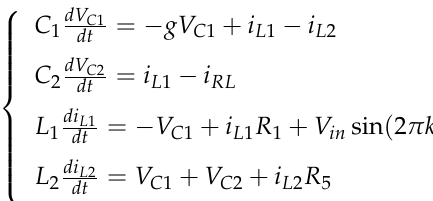
Figure 2. Diagram of Chua’s circuit.